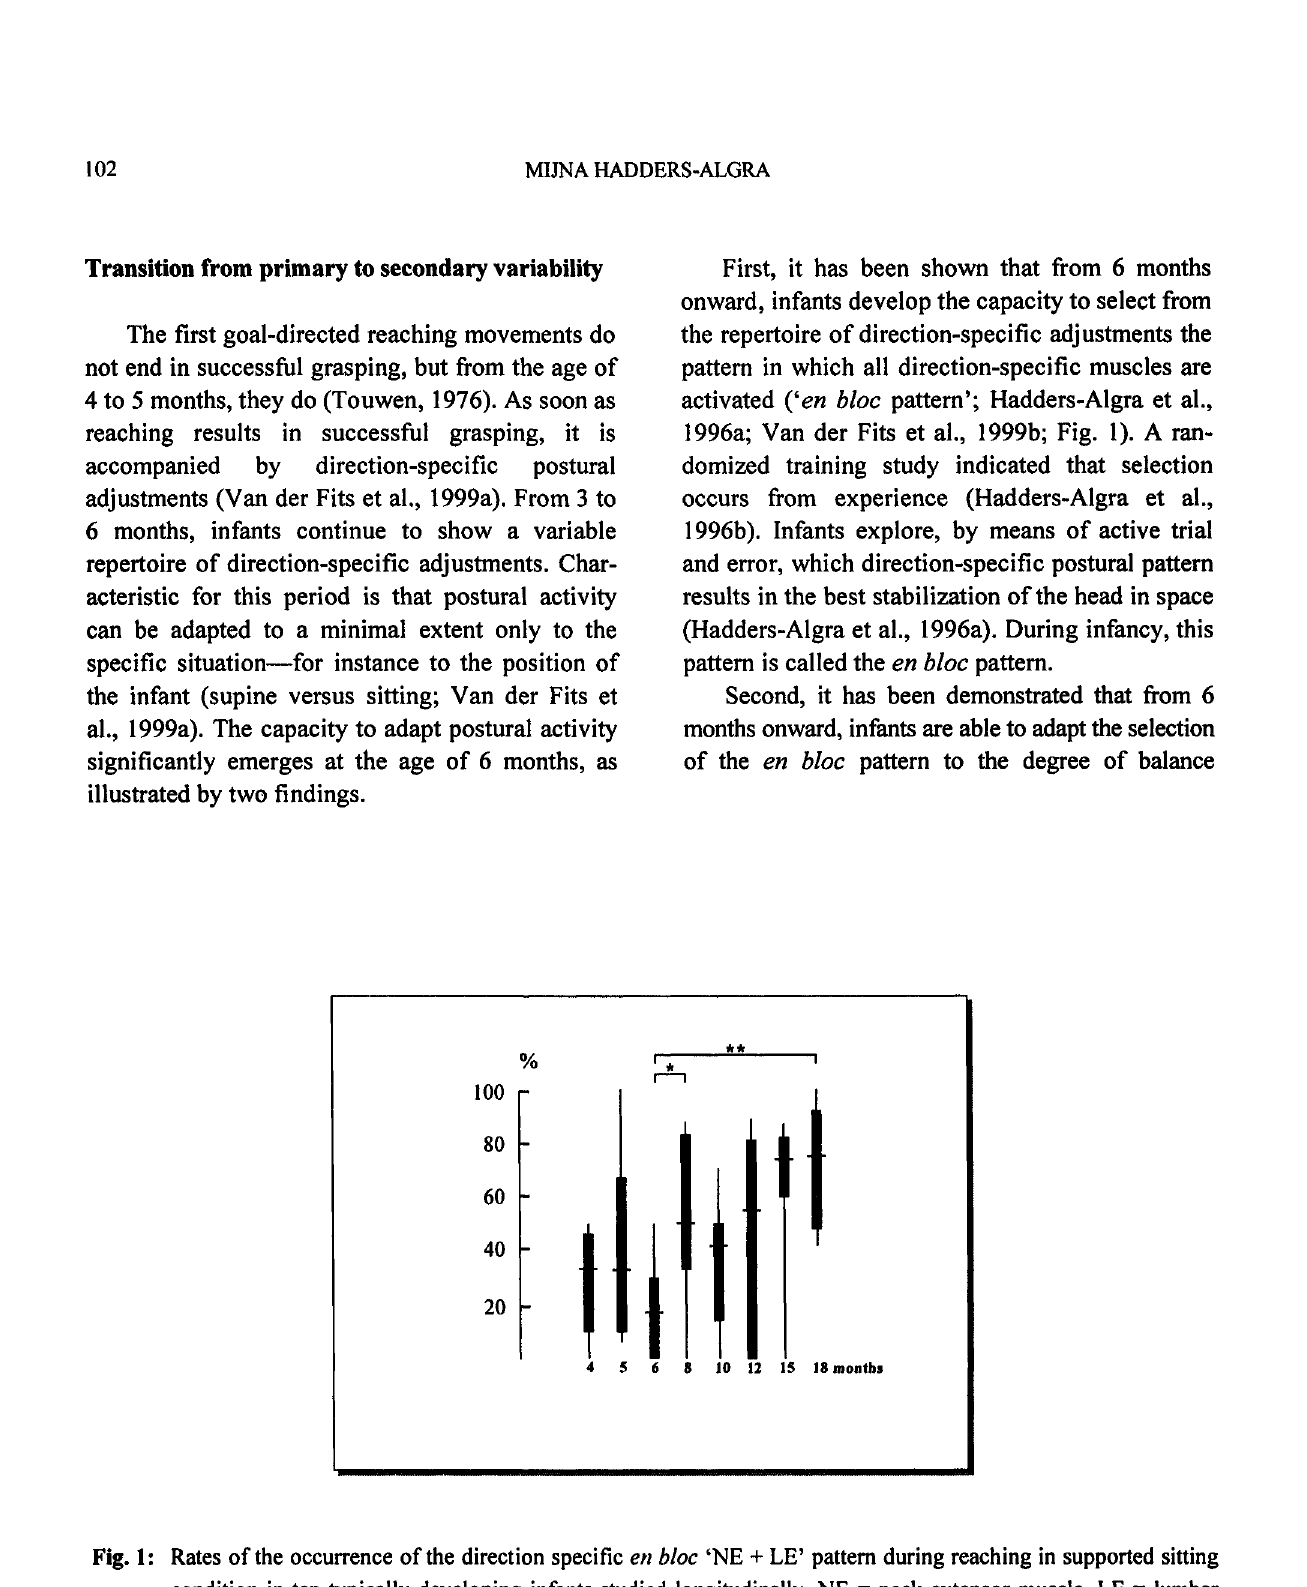
Fig. 1: Rates of the occurrence of the direction specific en bloc ’NE + LE’ pattern during reaching in supported sitting condition in ten typically developing infants studied longitudinally. NE neck extensor muscle, LE lumbar extensor muscle. Data are presented by ranges (vertical bars), interquartile ranges (boxes), and median values (horizontal bars). * p < 0.05, ** p < 0.01 (Mann Whitney test). Data based on Van der Fits et al.